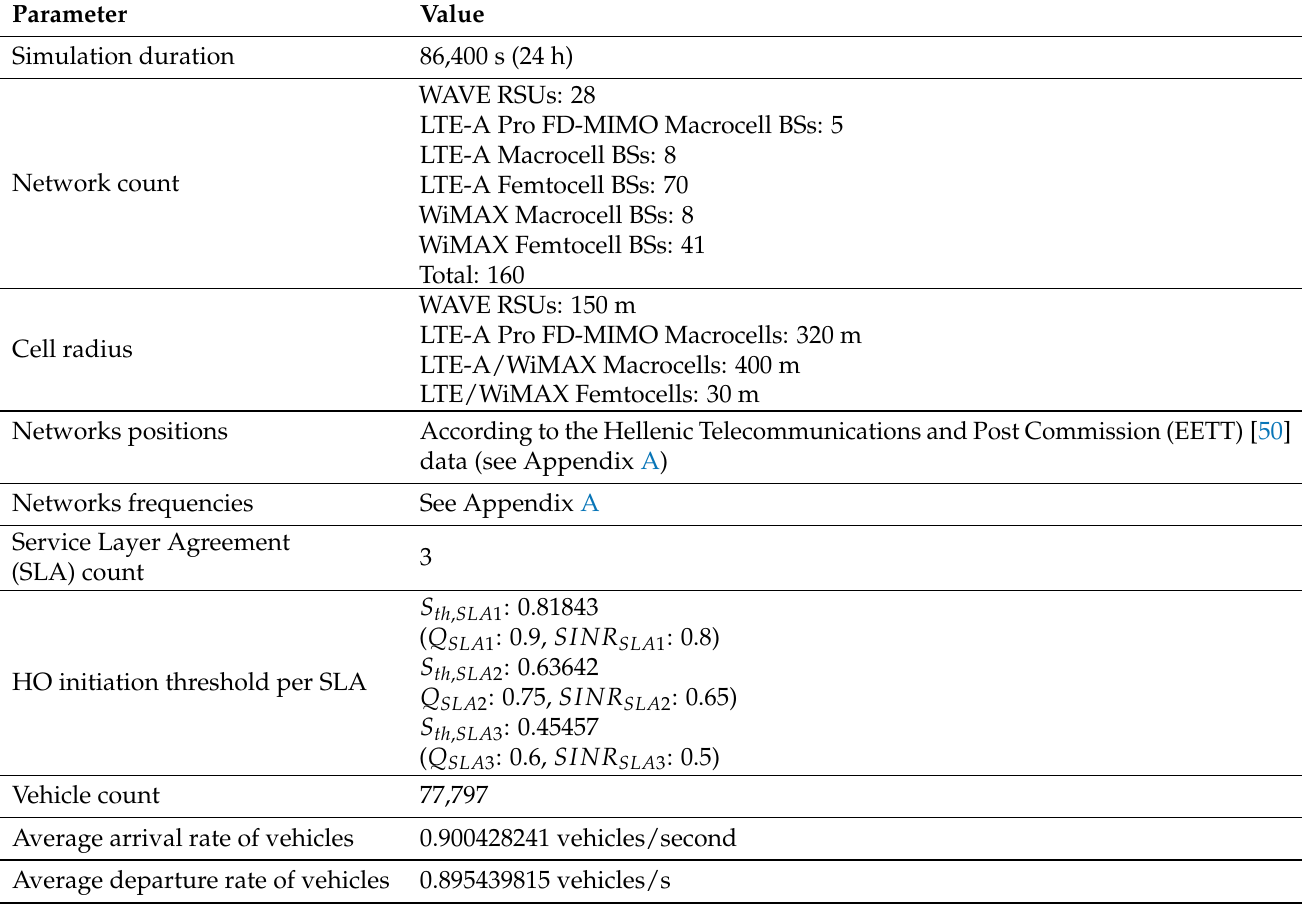
Table 1. The simulation